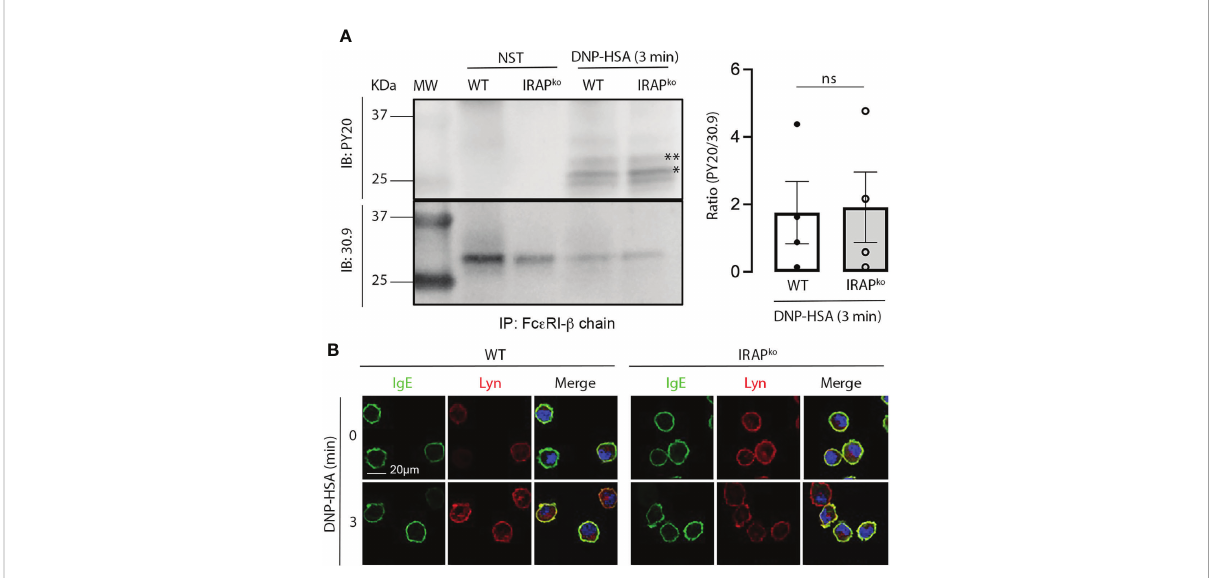
FIGURE 6 Absence of IRAP does not affect early signaling events mediated by Lyn kinase. (A) IgE-sensitized WT and IRAP-de fi cient (IRAP KO ) BMMCs were either not stimulated or stimulated with antigen (30 ng/mL of DNP-HSA) before being lysed and immunoprecipitated with anti-Fc e RI b chain mAb. Levels of co-immunoprecipitated phospho- b chain (**) and phospho- g chain (*) in non-reduced gels were determined using anti- phospho-tyrosine (PY20) Ab. Total immunoprecipitated Fc e RI receptors were determined after stripping and reblotting with anti-Fc e R b chain mAb. A representative blot and quantitative analysis of indicated number of experiments are shown in the left and right panels, respectively. Statistical analysis was done using a Student ’ s t-test. (B) WT and IRAP-de fi cient (IRAP KO ) BMMCs were sensitized with anti-DNP IgE and were then plated on fi bronectin-coated glass coverslips. Cells were stimulated with 30 ng/mL of DNP-HSA for indicated time points. After fi xation and permeabilization cells were stained with DAPI (blue), anti-IgE (green) and anti-Lyn (red) Abs as indicated. Cells were analyzed by confocal microscopy. Images show representative sections (out of 2 experiments) with multiple cells for IgE and Lyn single staining as well as the merge of all colors. ns, not signi fi